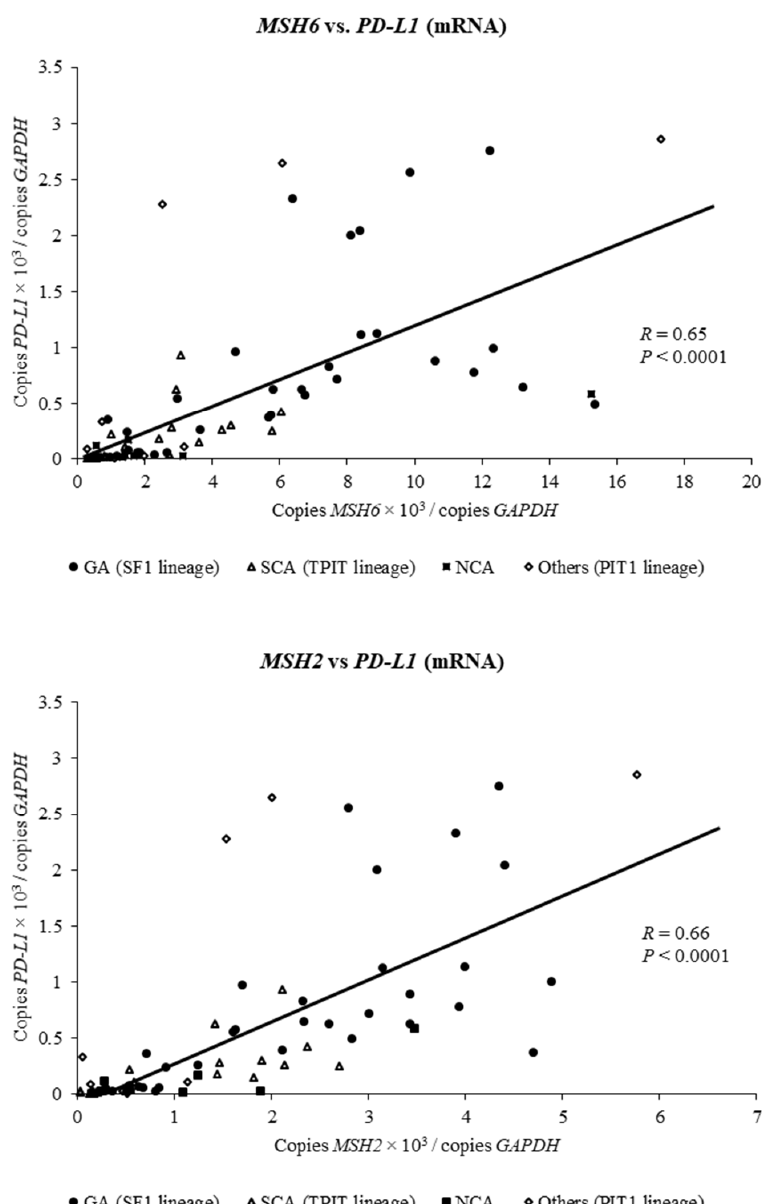
Figure 2. Correlation between MSH6 and MSH2 mRNA expression and PD-L1 mRNA expression in clinically nonfunctioning pituitary adenomas. The relationship between MSH6 and MSH2 expressions and PD-L1 expression in NFPAs was examined using simple linear regression analysis. MSH6 and MSH2 expression was positively associated with PD-L1 expression ( R = 0.65, p < 0.0001 and R = 0.66, p < 0.0001, respectively).